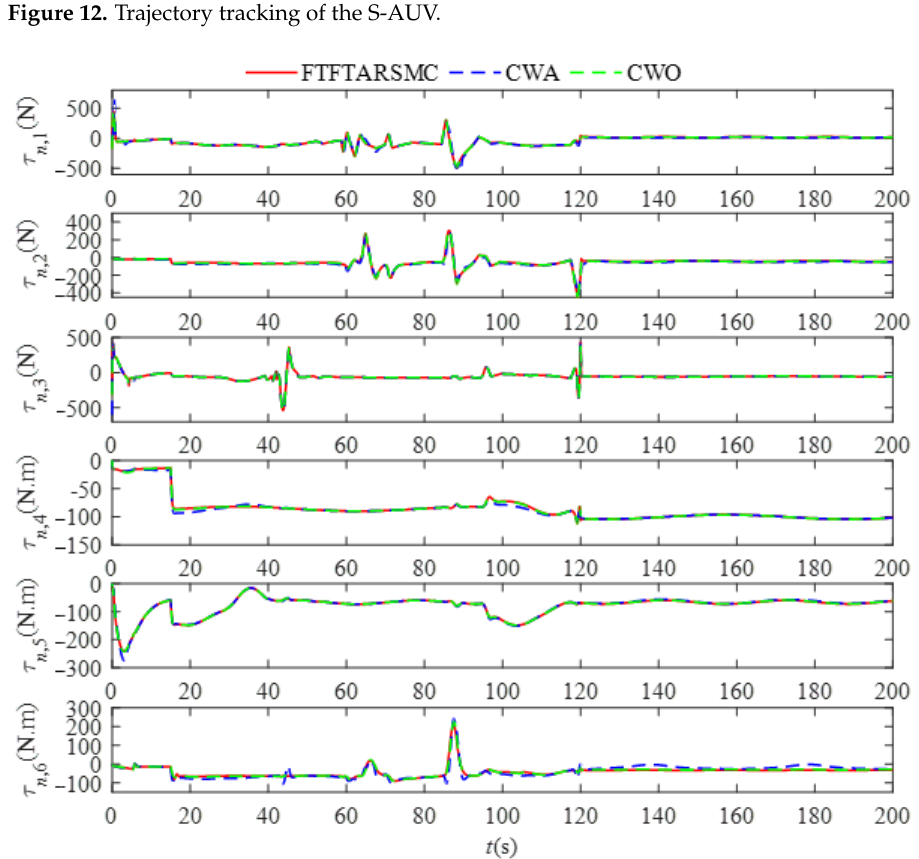
Figure 13. Control input.